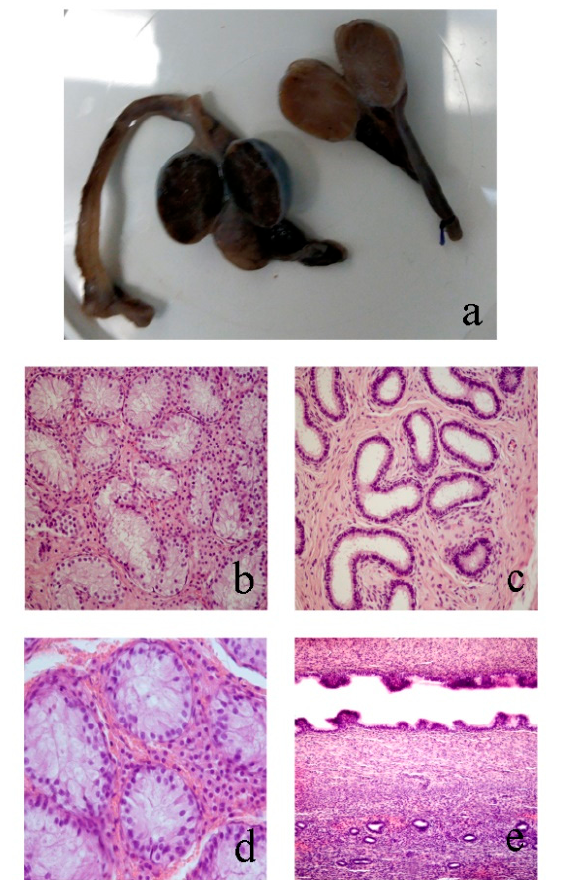
Figure 3. Case 3 ( a ) transversal sections of both the removed gonads; ( b ) section of the inguinal testis in which seminiferous tubules without spermatogenesis and many Leydig cells in the interstitium are evident (20 × ); ( c ) section of the epididymis in which empty tubules lined with columnar epithelium are shown (20 × ); ( d ) abdominal testis in which seminiferous tubules lined by Sertoli cells without germ cells are supported by interstitium with a hematic component and many Leydig cells (40 × ); ( e ) tubular structure with a lumen lined by simple epithelium forming short papillae and a dense fibrous layer with glandular structures are shown (20 × ). Hematoxylin–eosin staining.